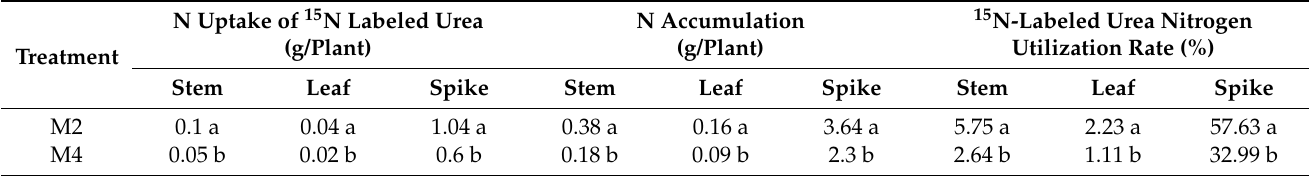
Table 7. Effects of plant density on nitrogen accumulation, 15 N accumulation, and distribution in each organ.